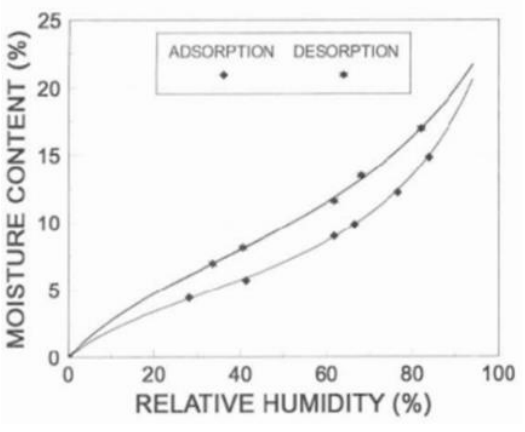
Figure 4. Sorption isotherm for wood.